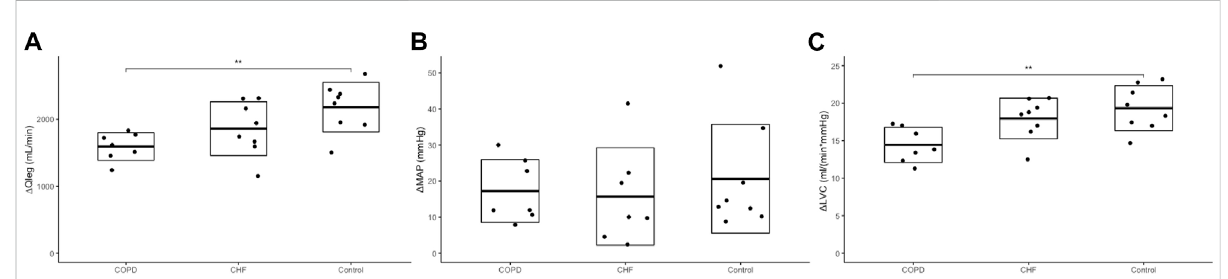
FIGURE 1 Haemodynamic responses. Panel (A) shows the change ( Δ ) in leg blood fl ow (Q leg ) from rest to one leg knee-extensor exercise at 10 W, panel (B) change in mean arterial pressure (MAP) and panel (C) change in leg vascular conductance (LVC). One-way ANOVA, with Tukey ’ s honest test was used to detect differences between groups marked with a *= ( p < 0.05) or **= ( p < 0.01). Dot plots with boxes showing mean and standard deviation withexact valuesfor eachparticipant. Chronicheartfailure(CHF) participants n=8,Chronicobstructive pulmonary disease(COPD) participants n = 7, healthy control n = 8.